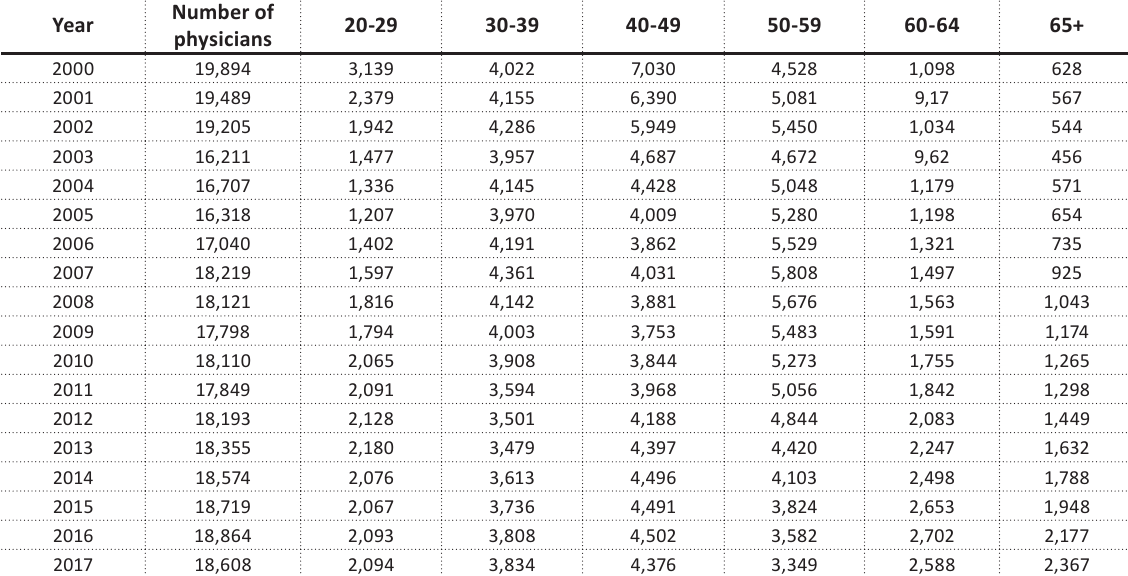
Source: National Center of Health Information (NCZI,